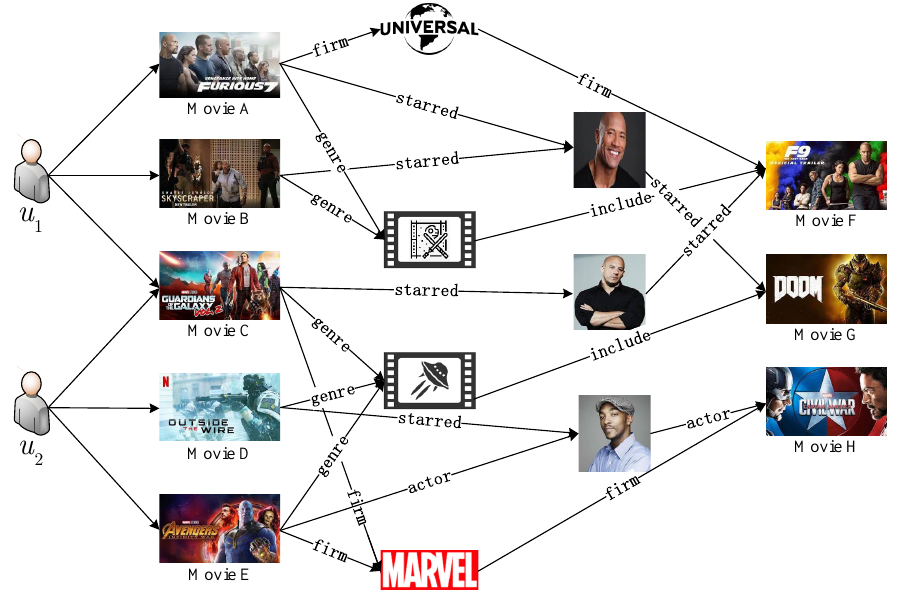
Figure 1. A movie recommendation knowledge